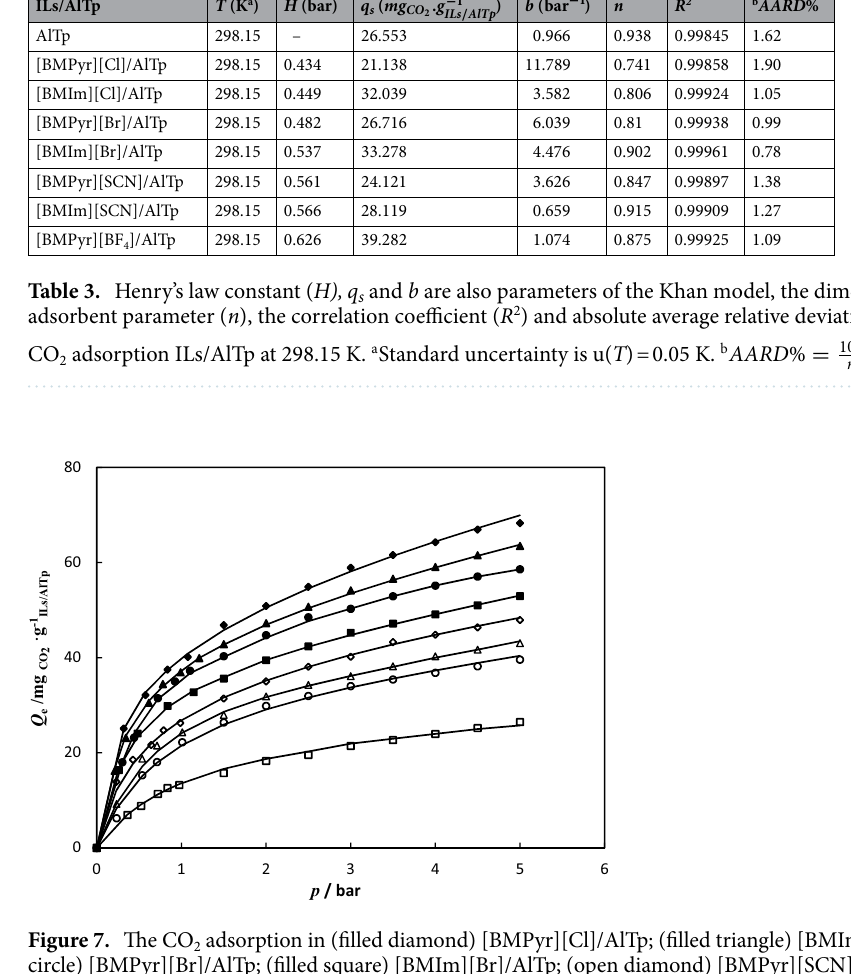
Figure 7. The CO 2 adsorption in (filled diamond) [BMPyr][Cl]/AlTp; (filled triangle) [BMIm][Cl]/AlTp; (filled circle) [BMPyr][Br]/AlTp; (filled square) [BMIm][Br]/AlTp; (open diamond) [BMPyr][SCN]/AlTp; (open triangle) [BMIm][SCN]/AlTp; (open circle)[BMPyr][BF 4 ]/AlTp at temperature 298.15 K; (straight line) Fitting results by Eq.